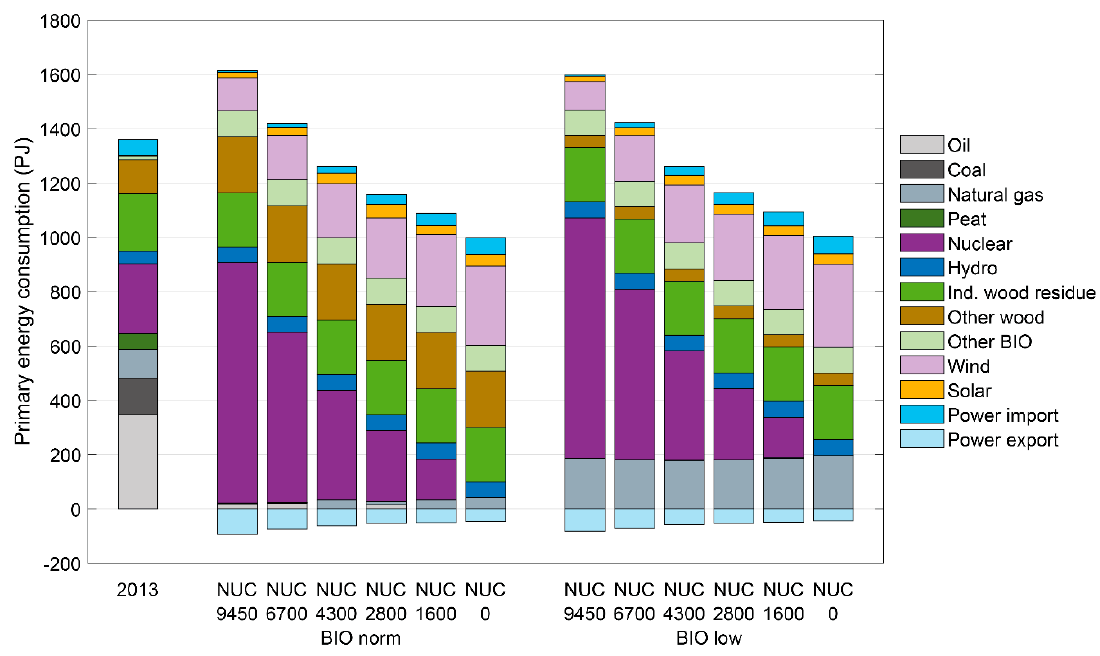
Figure 1. Primary energy consumption of the national case, without (“BIO norm”) and with biomass limitations (“BIO low”). The reference case, Finland in 2013, is shown on the left.